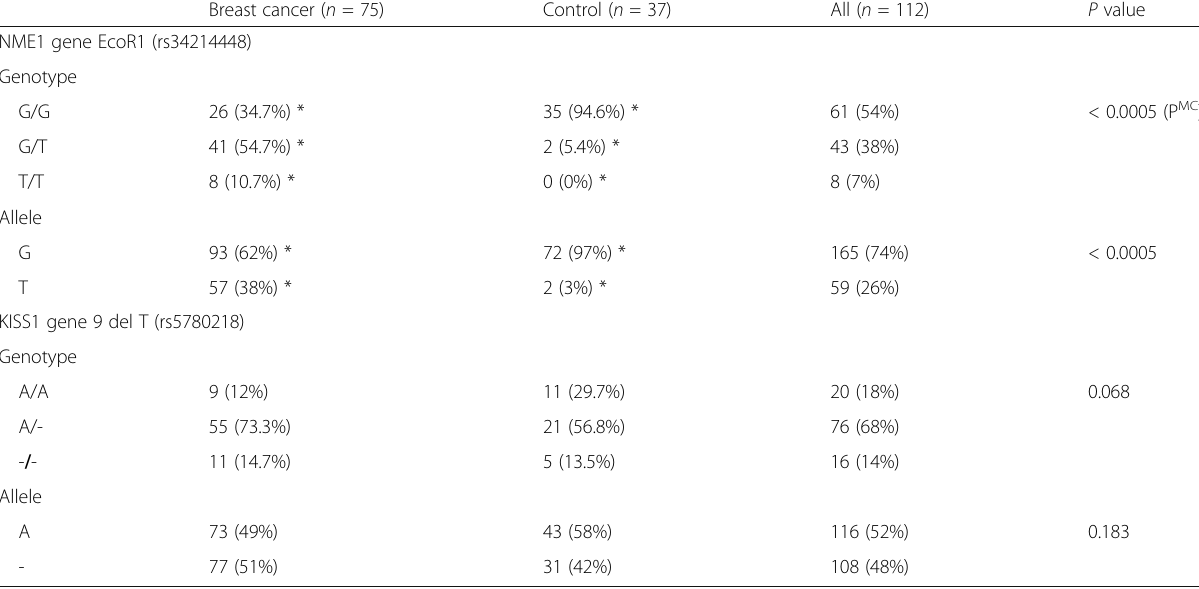
Table 2 Genotype and allele frequencies of NME1 gene EcoR1 (rs34214448) and KISS1 gene 9 del T (rs5780218) SNPs in breast cancer patients and